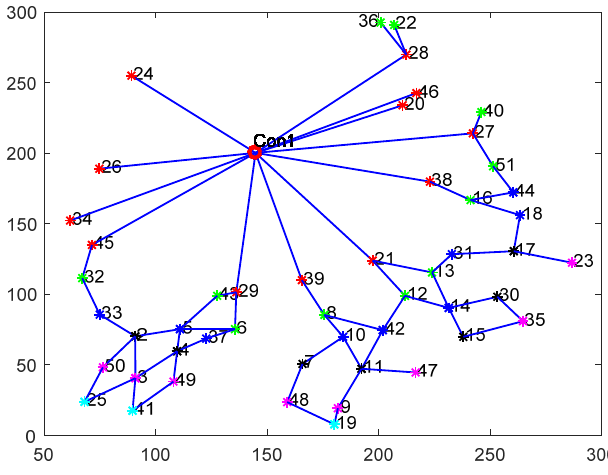
Figure 15. Logical topology after static relay selection. Table 1. α and β values of subnets at all levels.